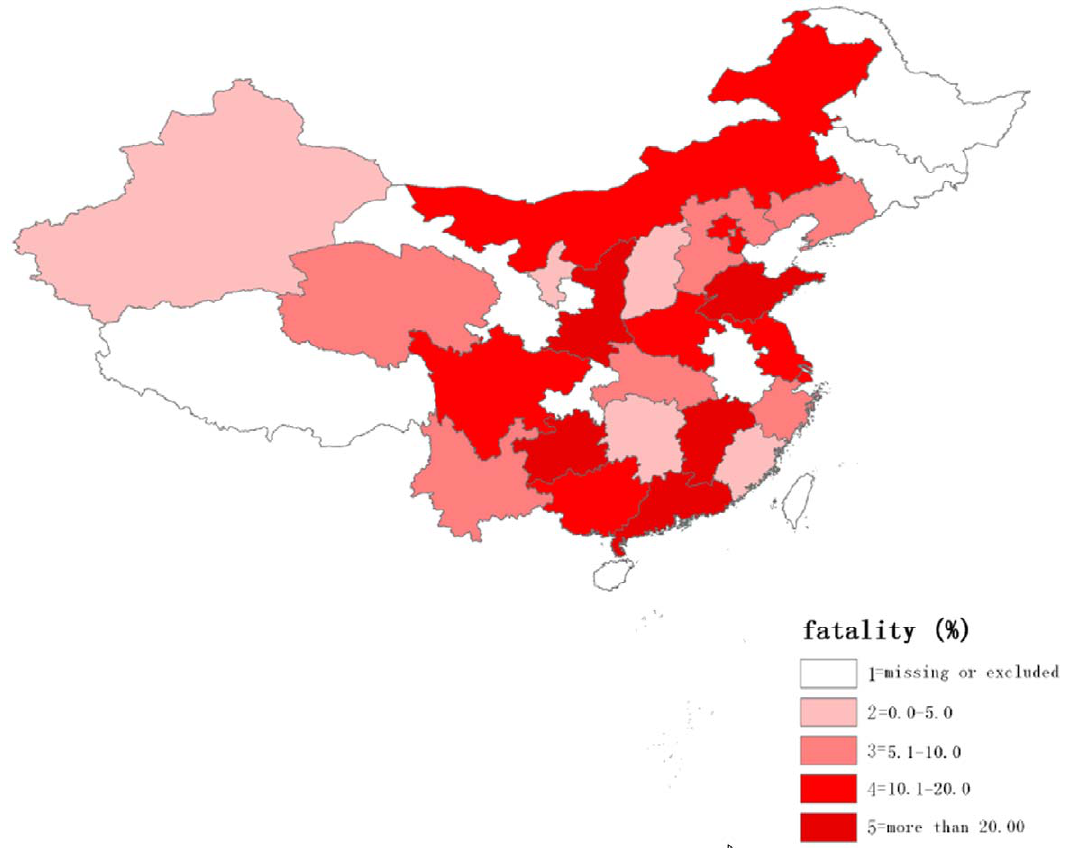
Figure 3. The regional distribution of case fatality rates for PE in China.